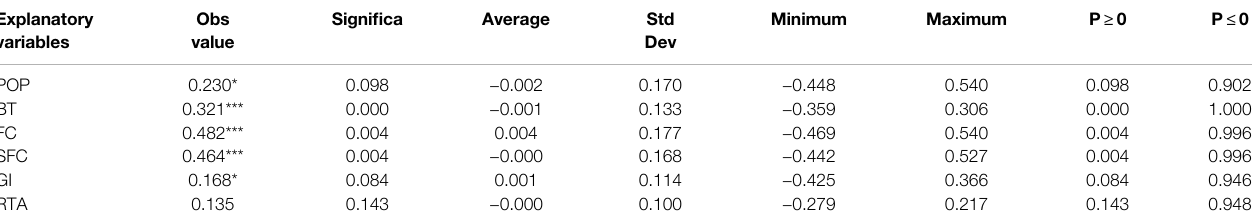
TABLE 4 | Results of QAP correlation analysis in 2000. Explanatory variables